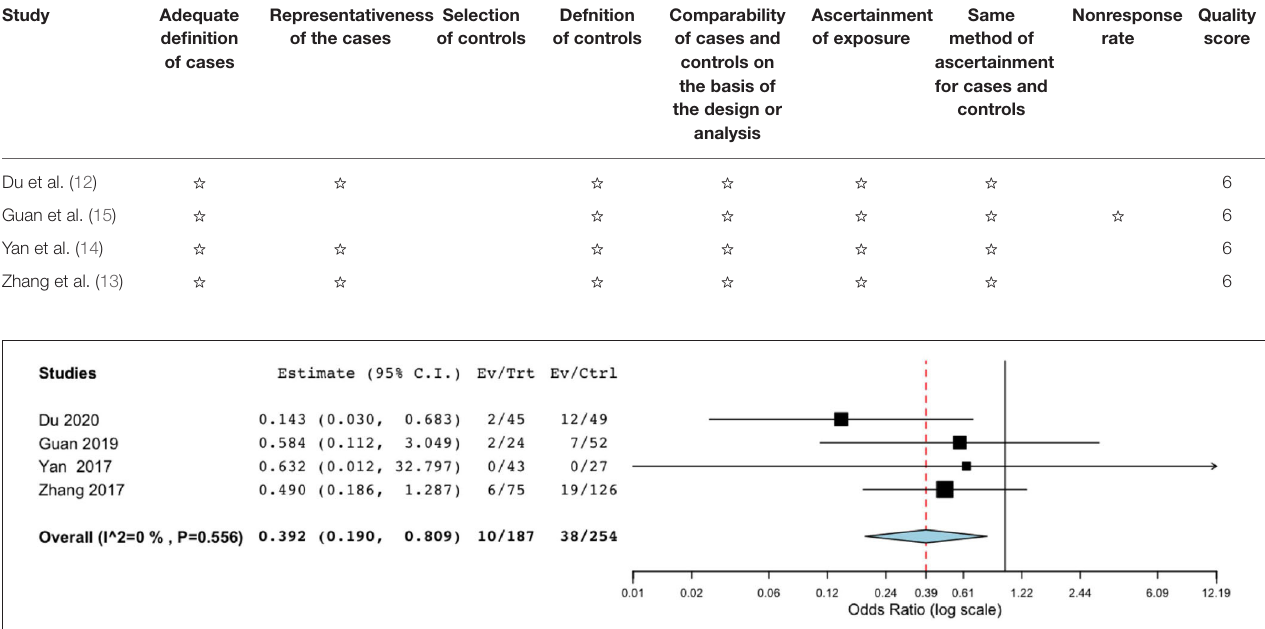
FIGURE 2 | Risk of postoperative recurrence in endoscope-assisted surgery and BHC groups. (OR of 0.392, 95% CI, 0.190–0.809 , P = 0.011, I 2 = 0 % ).